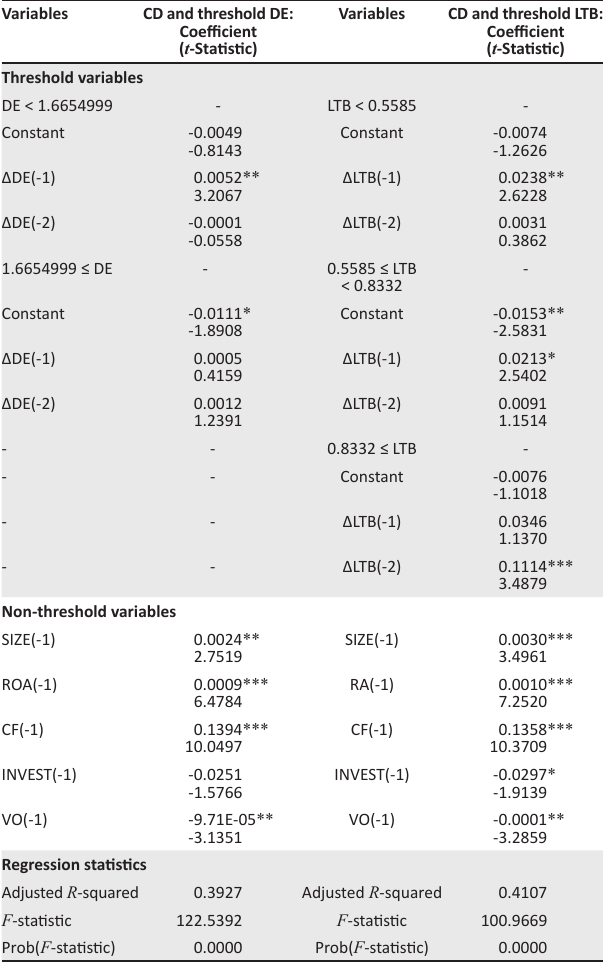
TABLE 2: Threshold regression approach for dividend payments and capital structure (trade-off theory): 1990–2017.